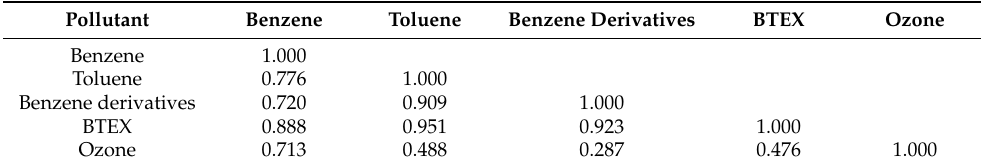
Figure 3. Monthly variation of ozone concentration. The non-parametric correlation between values of pollutant concentrations reveals toluene and benzene derivatives and ozone (Table 2). Table 2. Spearman’s correlation coefficients, r, for the studied compounds.